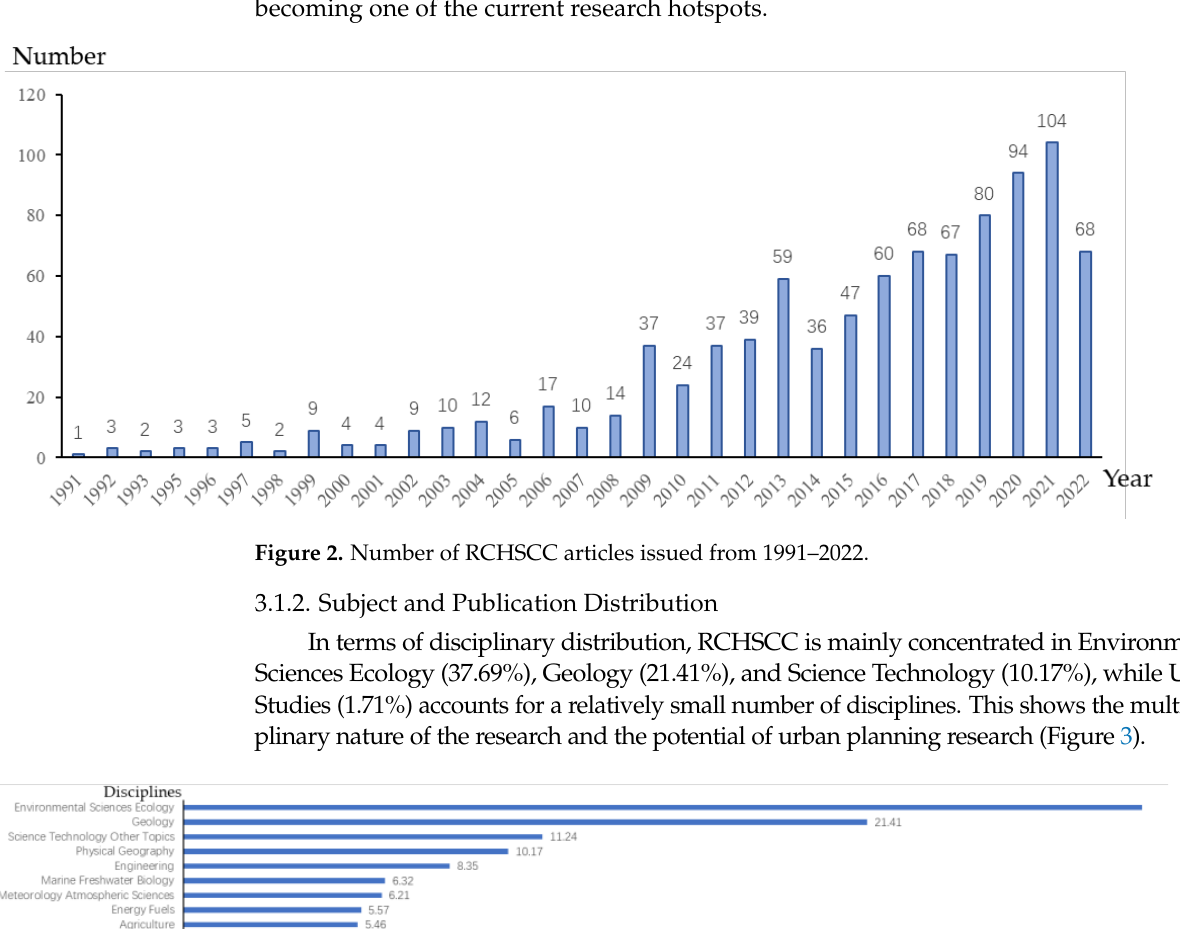
Figure 1. RCHSCC ’ s framework.